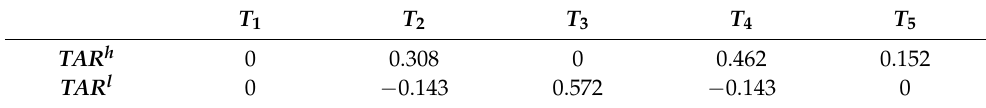
Table 5. Calculation of TAR for T 1 – T 5 .